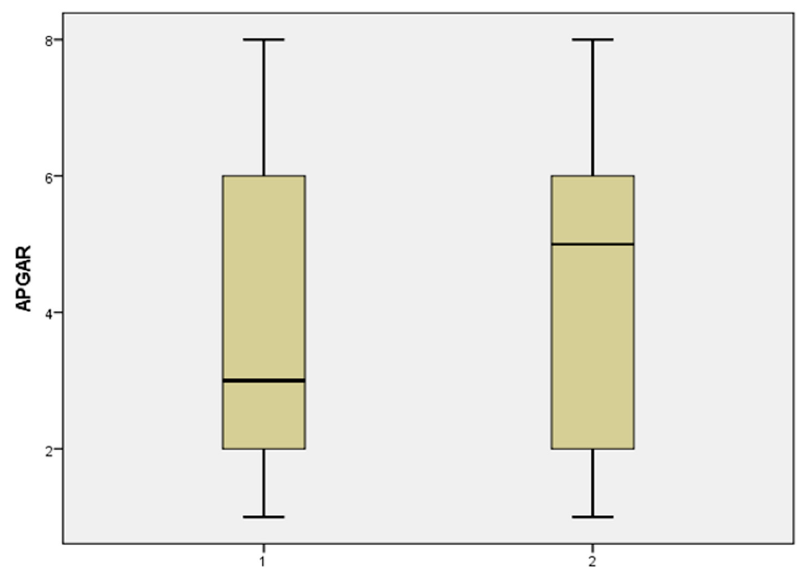
Figure 3. Distribution of Apgar score values in group 1 without latency vs. group 2 with latency,